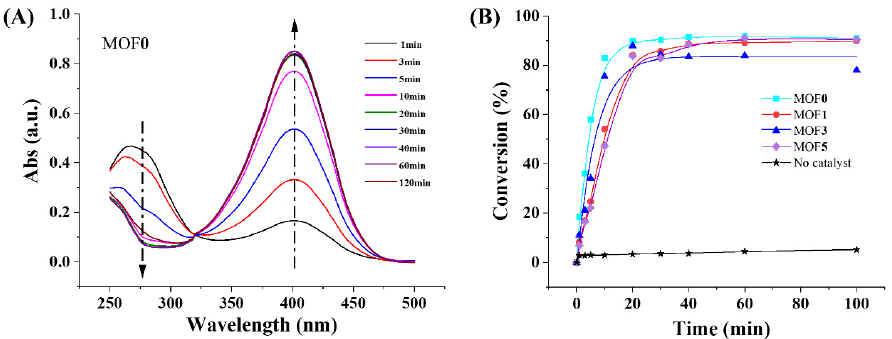
Figure 6. ( A ) Hydrolysis reaction for DMNP using MOF 0 as a catalyst, ( B ) conversion for the hydrolysis of DMNP in the presence of MOF 0 , MOF 1 , MOF 3 , and MOF 5 or without